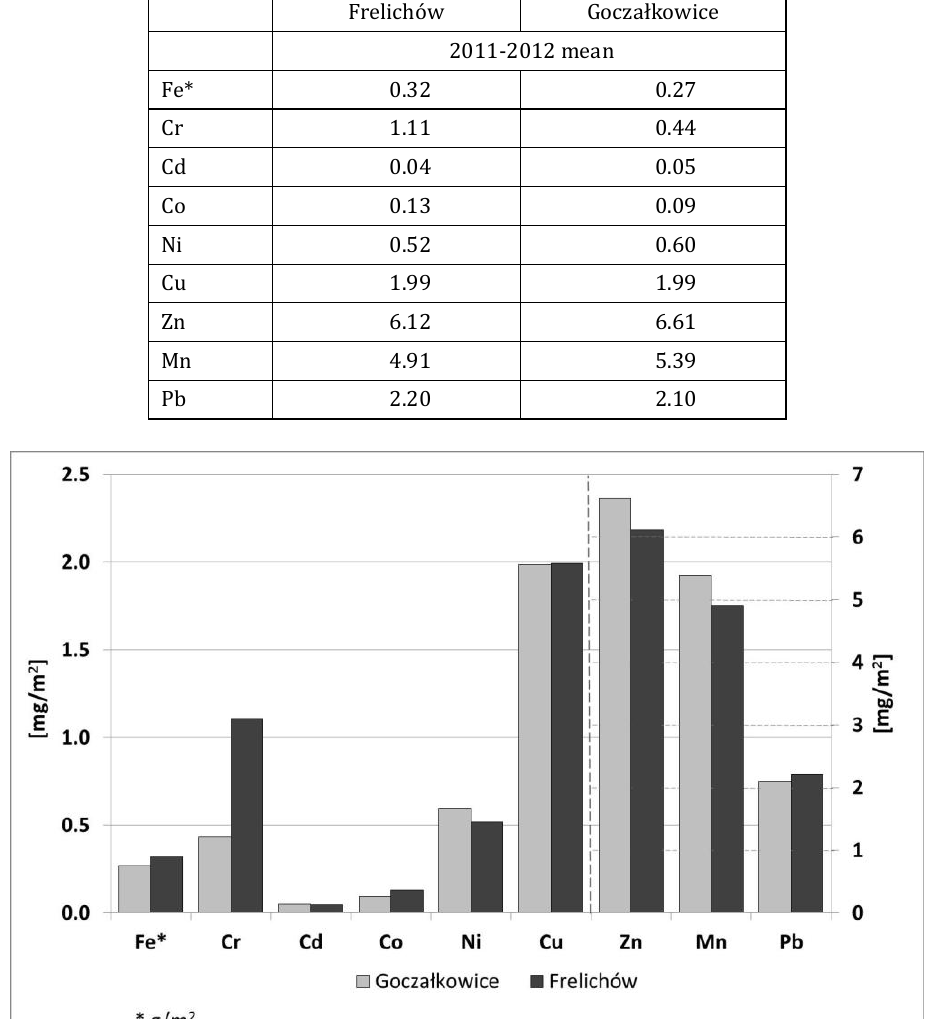
Table 7. Mean dry deposition values for Goczałkowice and Frelichów in 2011-2012 [mg/m 2 ], Fe* – [g/m 2 ]